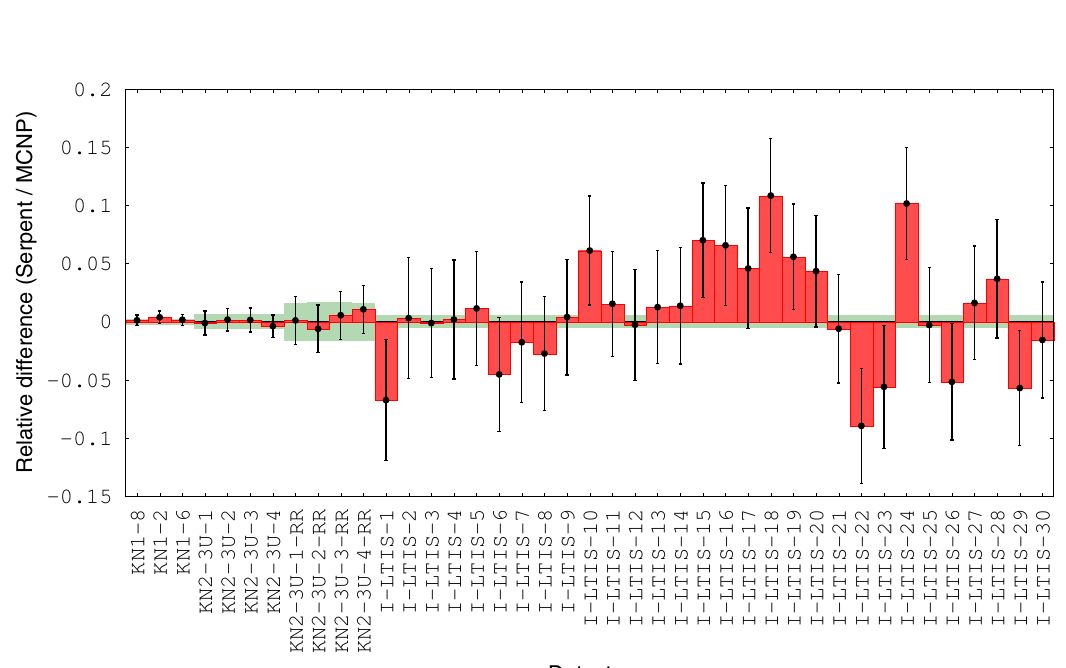
Figure 4: Relative difference of neutron fluxes between Serpent and MCNP for all detector position and reaction rates in DT plasma. The 1 σ uncertainty of MCNP is presented with the green bars while the 1 σ uncertainty of Serpent is presented with